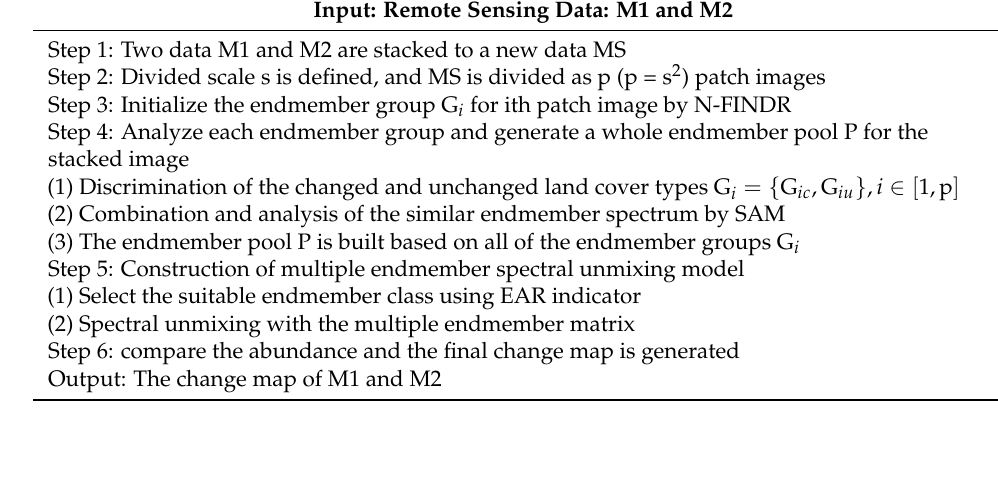
Table 1. The CD_SDSUVE methodology.